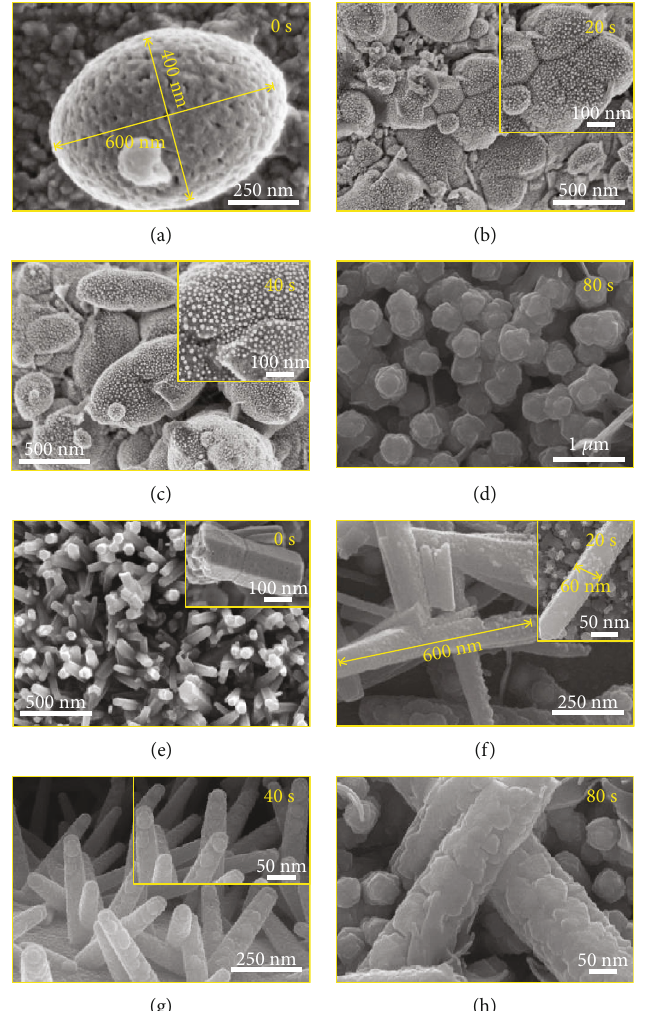
Figure 2: Morphological characterization of Au/ZnO thin fi lms with di ff erent Au sputtering times (0 s, 20s, 40s, and 80 s), respectively. (a) As-formed pristine ellipsoidal-like ZnO (E-ZnO). (b) top-view image of Au nanoparticle- (NP-) decorated E-ZnO with sputtering time 20 s; the inset is an enlarged view. (c) SEM images of Au NP-decorated E-ZnO with sputtering time 40s, the inset is a magni fi ed view. (d) Surface morphology of Au NP-decorated E-ZnO with sputtering time 80 s. (e) As-prepared pristine rod-like ZnO (R-ZnO) with enlarged view (inset). (f) Morphology of Au NP-decorated R-ZnO with sputtering time 20s and the inset is a magni fi ed view. (g) Side-view image of Au NP- decorated R-ZnO with sputtering time 40s and the inset is a high-resolution view. (h) High-resolution SEM image of Au NP-decorated R- ZnO with sputtering time